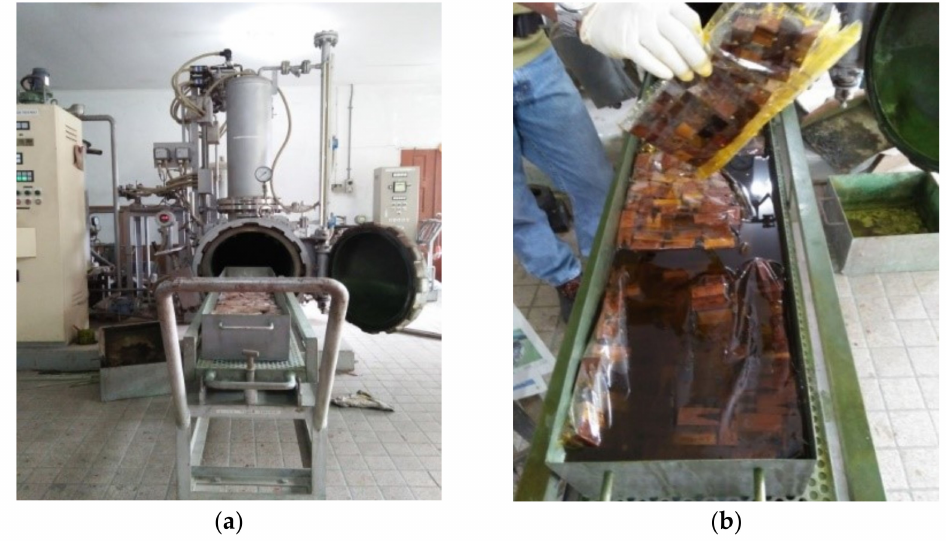
Figure 5. Timber treatment process. ( a ) Samples are placed in a treatment cylinder. ( b ) Samples were treated by using copper chrome arsenic